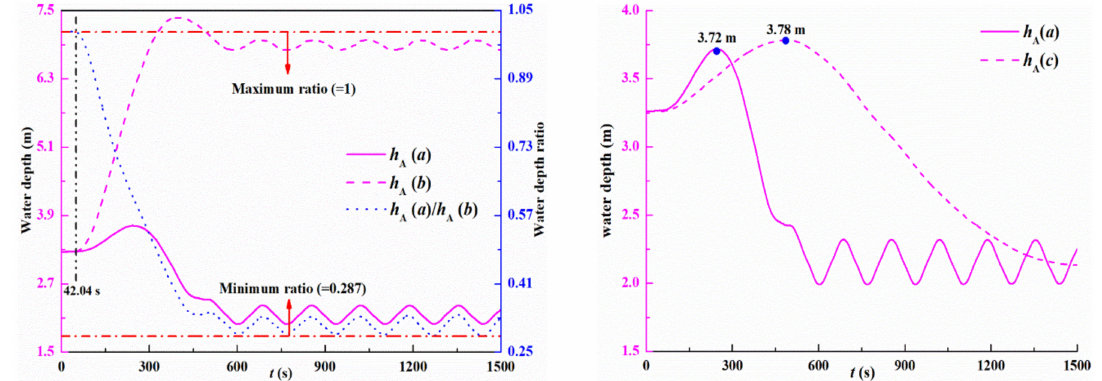
Figure 7. ( a ) Influence of EDB location on water depth and water depth ratio of the energy dissipating box (schemes a and b ); ( b ) water depth change of the energy dissipating box in schemes a and